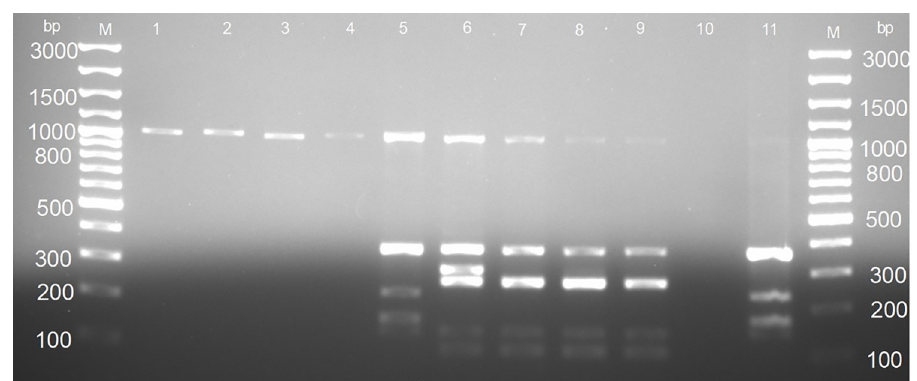
Fig 2. Agarose gel electrophoresis of the Mycobacterium tuberculosis complex differential PCR assay. Lane M: GeneRuler 100 bp (Invitrogen, Thermo Fischer Scientific, South Africa), lanes 1–4: Non-tuberculosis mycobacteria (NTM) which amplified 1030 bp; lane 5: M . tuberculosis which amplified 1030 bp, 372 bp, 235 bp, 172 bp, and 146 bp; lanes 6–9: M . bovis which amplified 1030 bp, 372 bp, 146 bp, and 108 bp; lane 10: sterile ultrapure water used as negative control; lane 11: M . tuberculosis reference strain